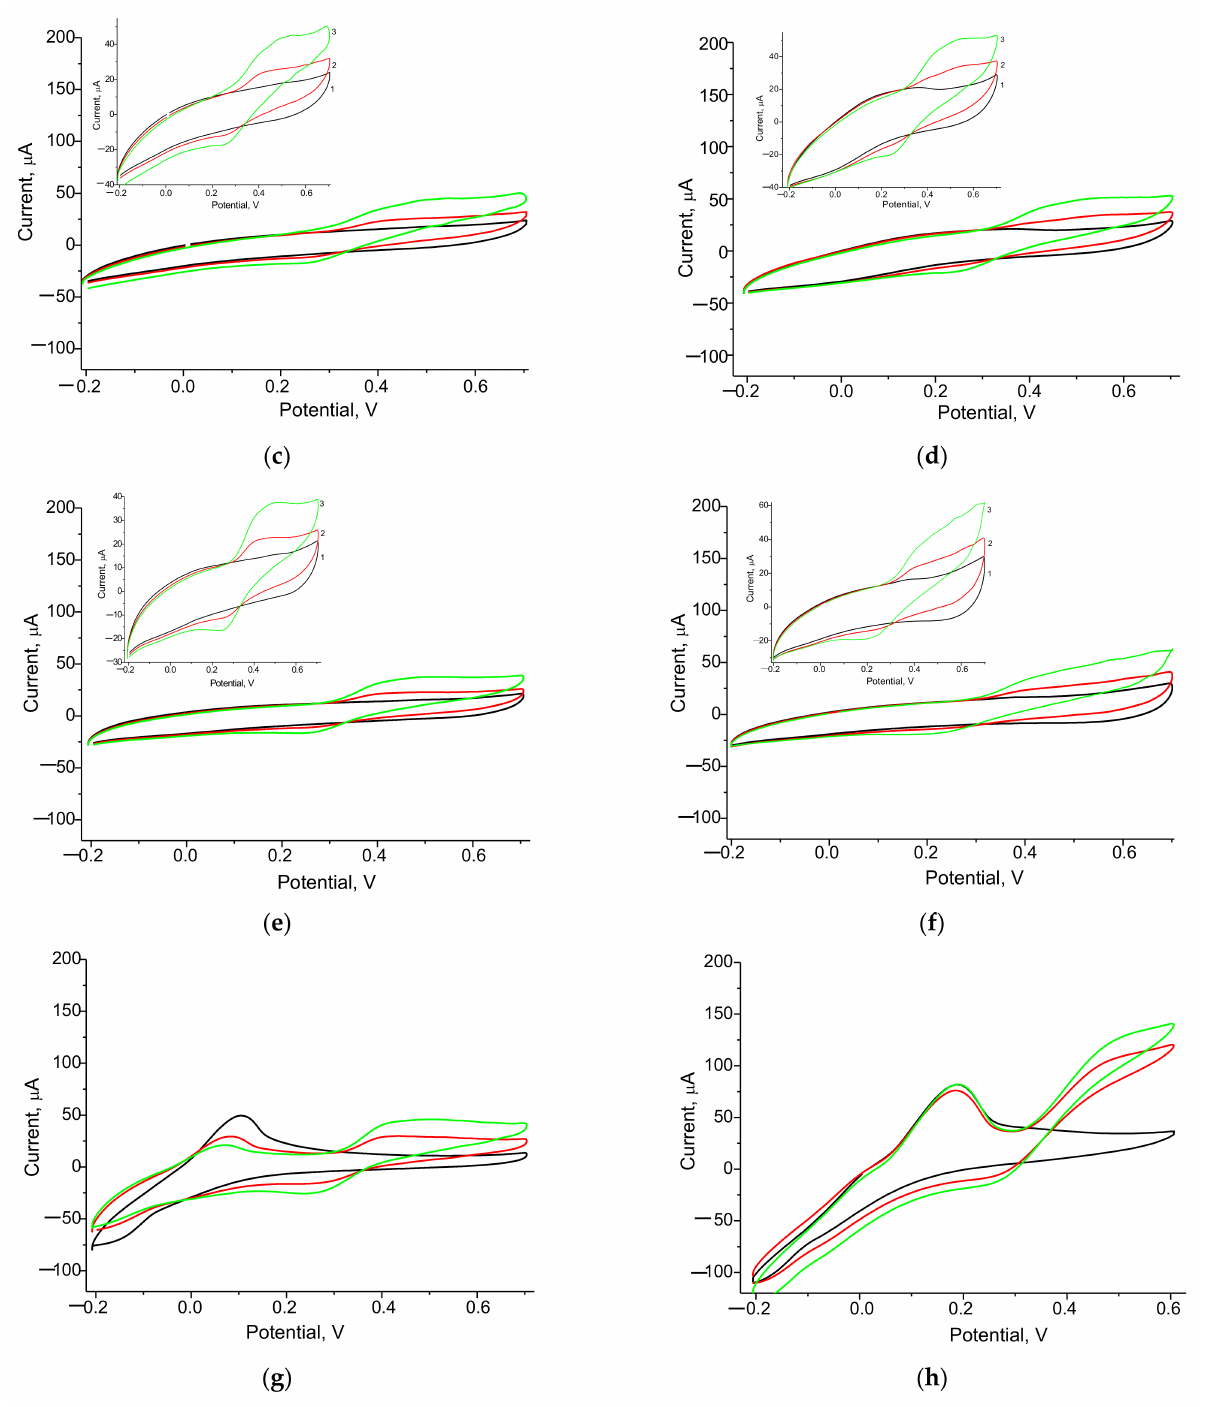
Figure 3. Cyclic voltammograms for the constructed ABSs, as current responses upon addition of catechol in varying concentrations: 0 mM (1, black), 0.25 mM (2, red); 0.50 mM (3, green). ABSs: laccase/GE ( a ), laccase/PdHCF/GE ( b ), laccase/PtHCF/GE ( c ), laccase/AuHCF/GE ( d ), lac- case/AgHCF/GE ( e ), laccase/PtCeHCF/GE ( f ), laccase/NiPtPd/GE ( g ), and laccase/CuCo/GE ( h